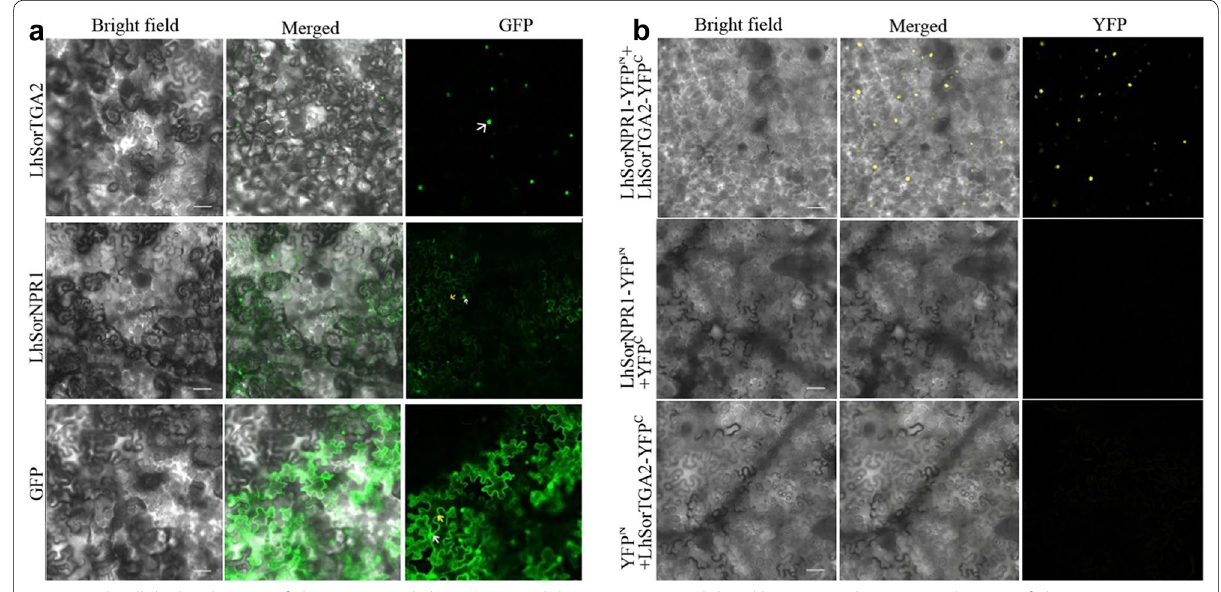
Fig. 3 Subcellular localization of LhSorTGA2 and LhSorNPR1, and their interaction validated by BIFC in planta. a Localization of LhSorTGA2 and LhSorNPR1 in N. benthamiana leaf epidermal cells. b BIFC analysis to validate the protein interaction between LhSorTGA2 and LhSorNPR1. LhSorNPR1 was fused to the N-terminal, while LhSorTGA2 was fused to the C-terminal half of YFP protein. Yellow fluorescence indicated protein interaction between LhSorTGA2 and LhSorNPR1 in the nuclei. Fluorescence was observed by confocal microscopy, and bright field and merged images were also shown for each observation. White arrows indicate nuclei of epidermal cells, and yellow arrows indicate the cytomembrane. Bar 100 =